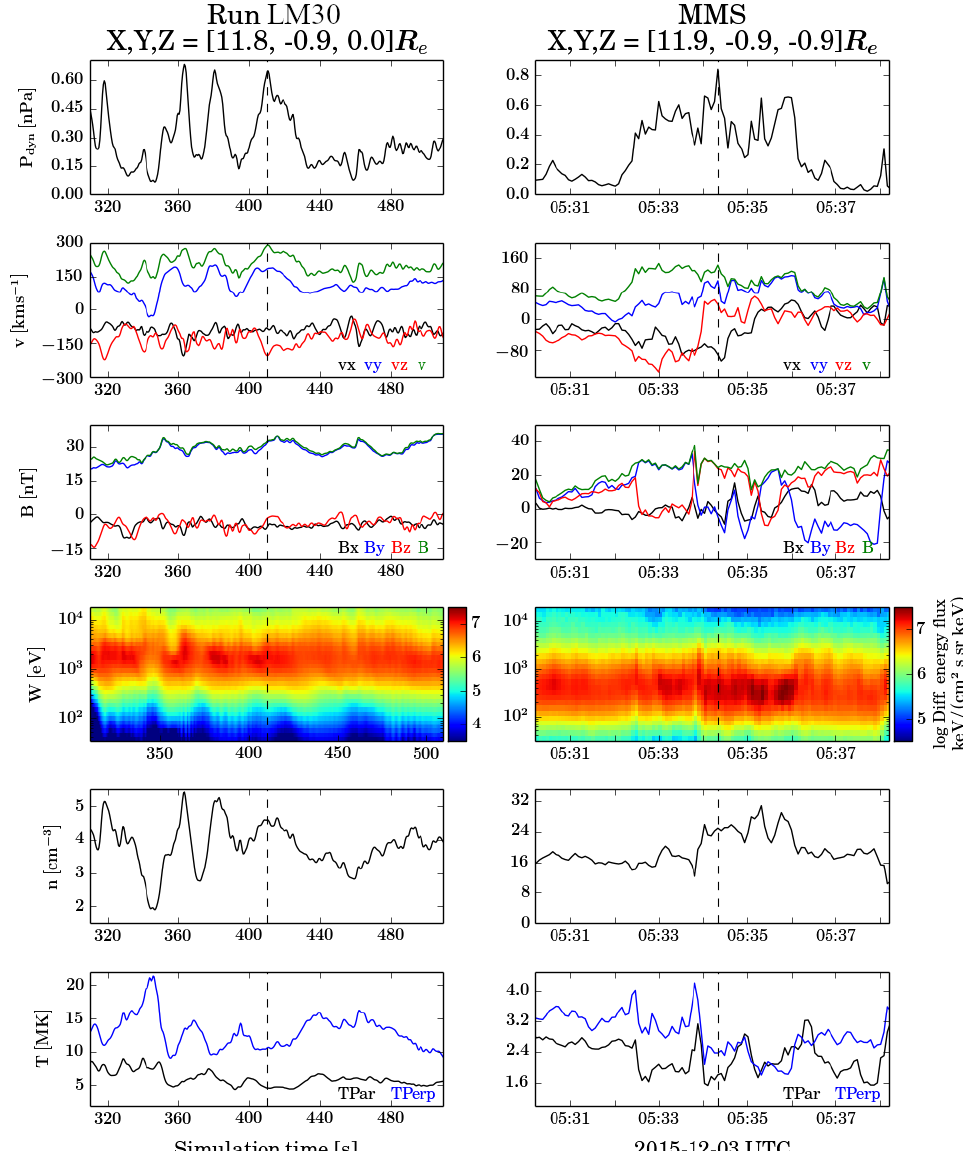
Figure 2. Left column: virtual spacecraft. Right column: MMS data from the position indicated by a star in Fig. 1a and b. The position is given in GSE coordinates in Earth radius ( R E ), added above the panels. The positions are close to each other but not identical because the Vlasiator velocity distributions are not saved everywhere. From top to bottom in both Vlasiator and MMS, we show the dynamic pressure, three components and the magnitude of the velocity, three components and the magnitude of the magnetic field, the ion energy–time spectrogram, density, and